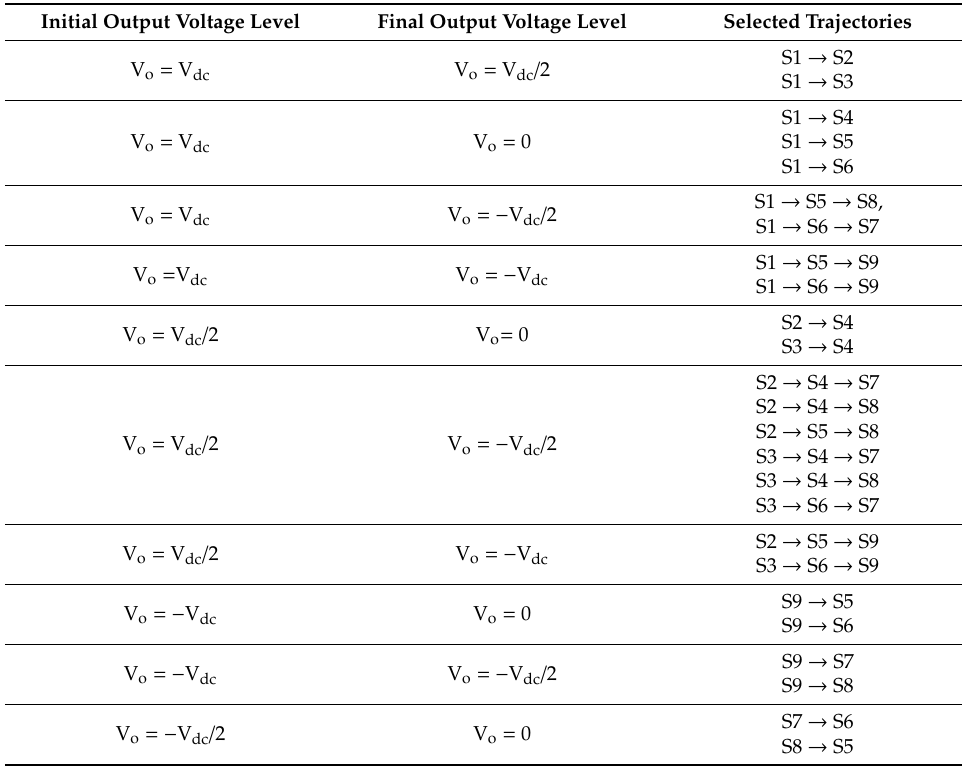
Table 3. Transitions and possible trajectories when passing from one voltage level to another (Case where i(t) > 0).